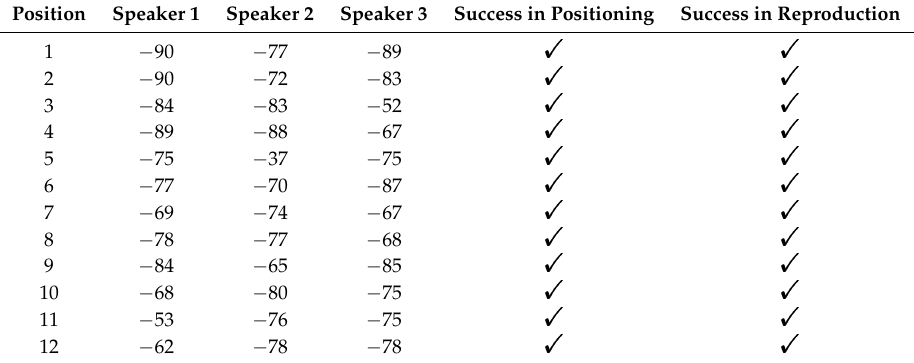
Table 2. Detecting position of Sufferer, based on the Bluetooth ID device RSSI, as measured by the smart speakers. The measures correspond to the first test set (user = Familiar1).